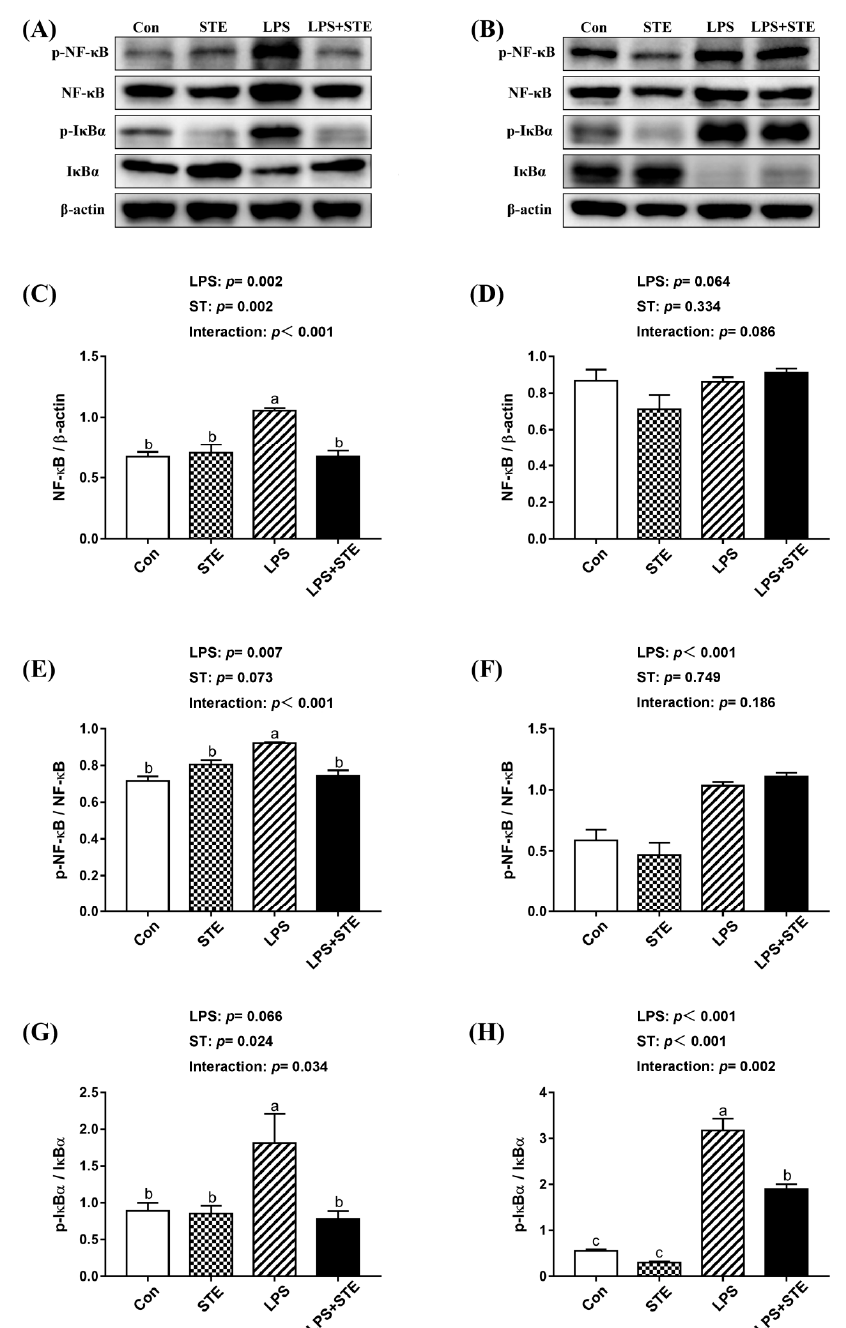
Figure 2. E ff ects of stevioside supplementation on the protein expression of NF- κ B, p-NF- κ B, I κ B α and p-I κ B α . ( A ) Western blot analysis of NF- κ B, p-NF- κ B, I κ B α and p-I κ B α in the jejunal mucosae. ( B ) Western blot analysis of NF- κ B, p-NF- κ B, I κ B α and p-I κ B α in the ileal mucosae. ( C ) Statistical analysis of NF- κ B / β -actin in the jejunal mucosae. ( D ) Statistical analysis of NF- κ B / β -actin in the ileal mucosae. ( E ) Statistical analysis of p-NF- κ B / NF- κ B in the jejunal mucosae. ( F ) Statistical analysis of p-NF- κ B / NF- κ B in the ileal mucosae. ( G ) Statistical analysis of p-I κ B α / I κ B α in the jejunal mucosae. ( H ) Statistical analysis of p-I κ B α / I κ B α in the ileal mucosae. CON, non-challenged broilers fed a basal diet; STE, non-challenged broilers fed a basal diet supplemented with 250 mg / kg stevioside; LPS, LPS-challenged broilers fed a basal diet; LPS + STE, LPS-challenged broilers fed a basal diet supplemented with 250 mg / kg stevioside. Data are presented as mean value ± SEM ( n = 6). a,b,c Means with di ff erent letters are significantly di ff erent ( p <